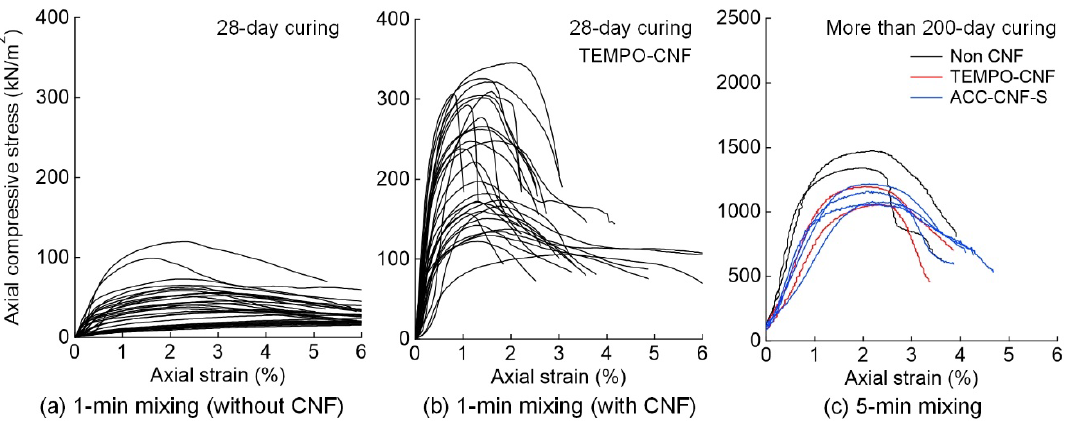
Figure 11. Relation between stress and strain in unconfined compression tests (Method 2).